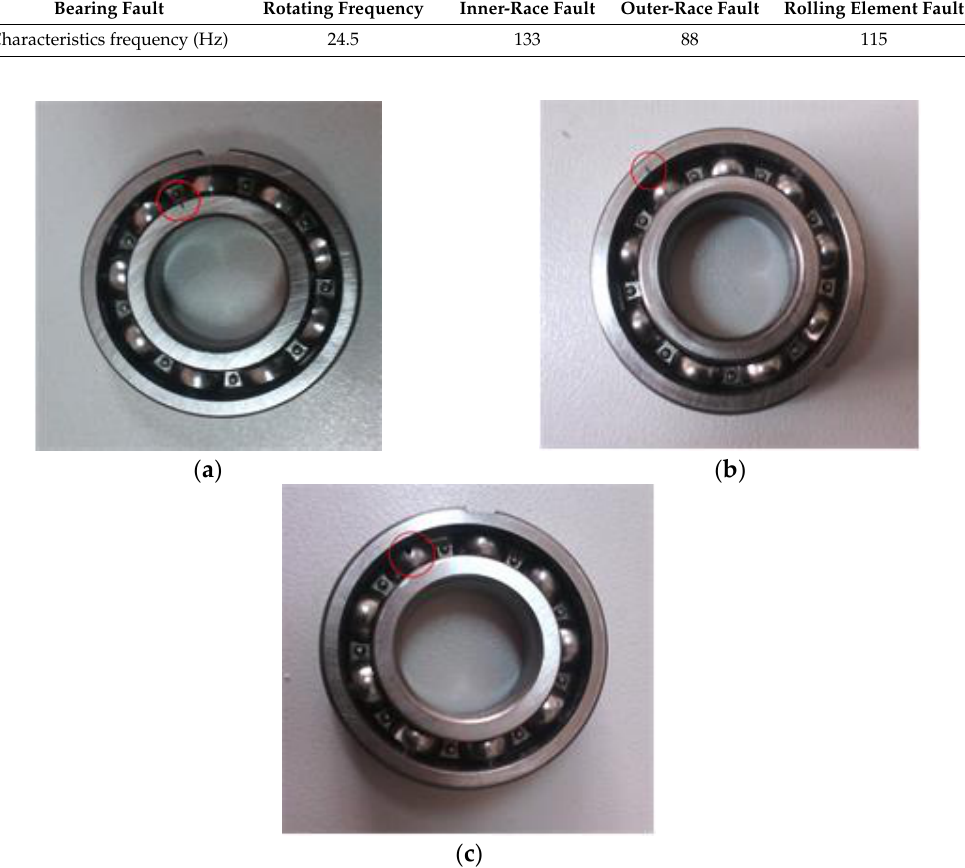
Figure 7. Three fault conditions of the faulty bearings: ( a ) Inner-race fault; ( b ) outer-race fault; ( c ) rolling element fault.